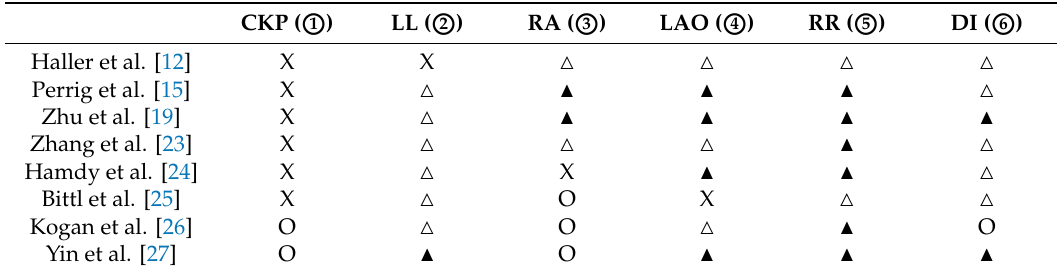
Table 4. Taxonomy of hash chain research applicable to VMF authentication